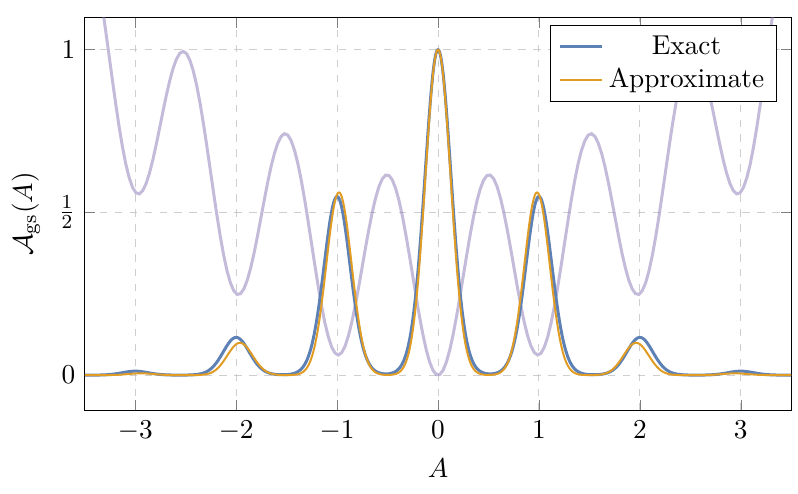
Figure 10. A comparison of the exact (i.e. found numerically) and approximate ground state wavefunction (6.3) with fg = 200 and q = 10. We include a schematic representation of the potential (purple) as a visual